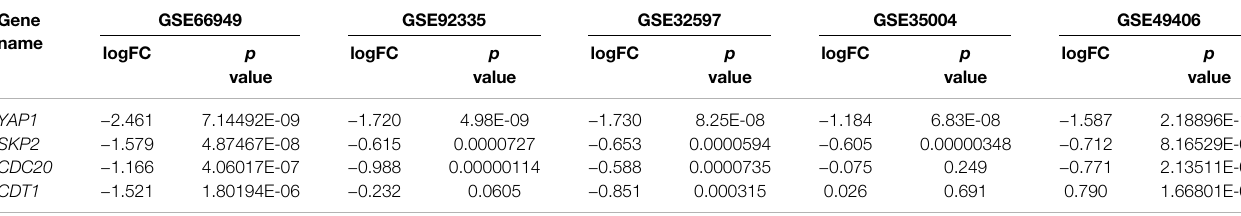
TABLE 2 | The expression change of YAP1 , SKP2 , CDC20, and CDT1 based on the inhibition of YAP1 in 5 GEO